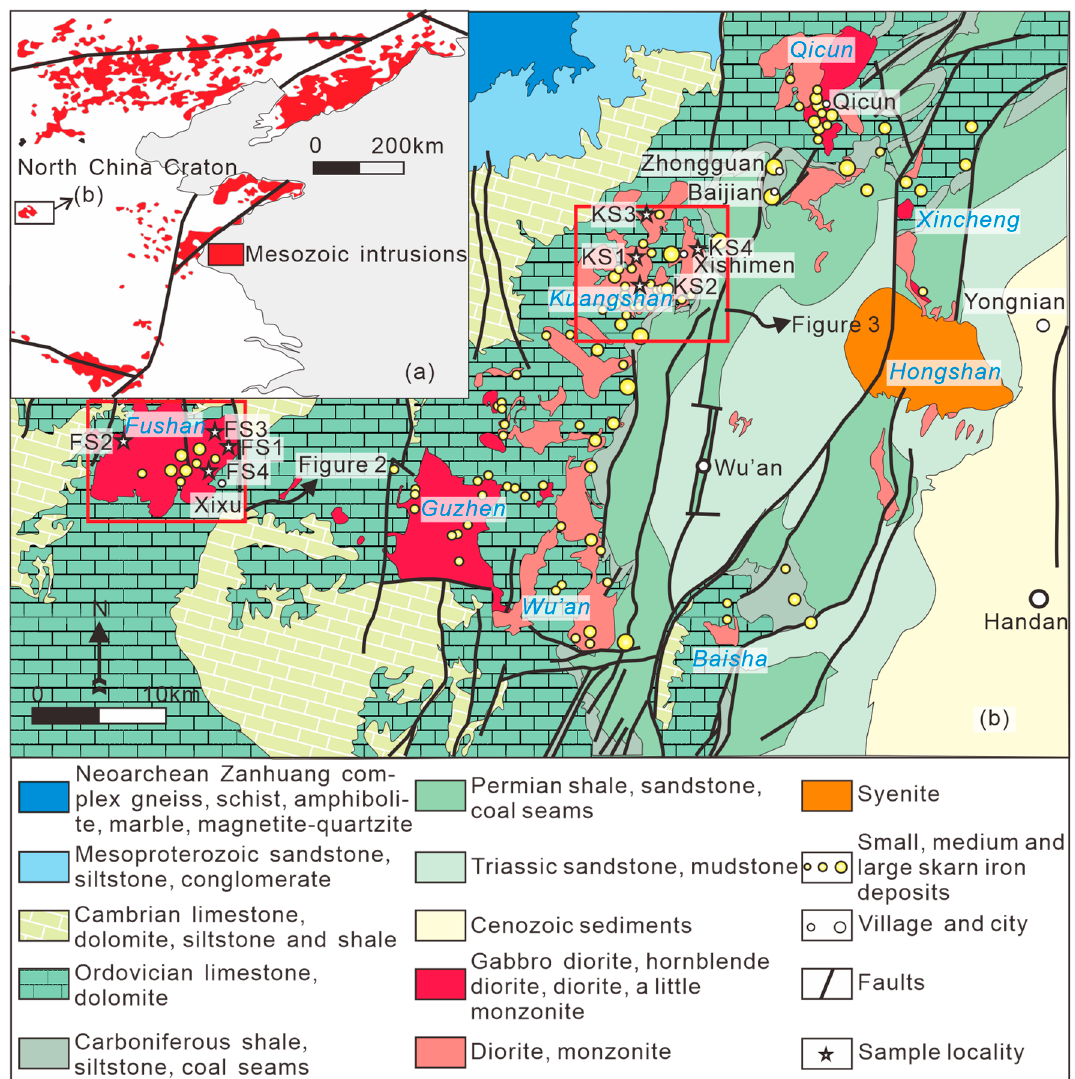
Figure 1. ( a ) Geological map of the North China Craton (revised from [52]); ( b ) Geological map of the Han–Xing region (revised from [34]).